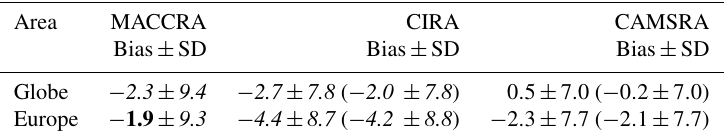
Figure 11. Time series of monthly mean surface ozone MNMB between the three reanalyses and GAW O 3 data averaged over (a) the globe and (b) Europe. Globally about 60–70 stations were available from 2003 to 2014, dropping to about 40–50 in 2015 and then dropping steeply to only a few during 2016. In Europe, the number dropped from 25–35 in 2003–2014 to 17–19 in 2015. CAMSRA is shown in red, CIRA in blue and MACCRA in green. Table 4. Mean biases and standard deviations from MACCRA, CIRA and CAMSRA relative to GAW surface O 3 data (shown in Fig. 11; in ppb). The values are calculated for the period 2003–2012, and the values in brackets are calculated for CIRA and CAMSRA for the period 2003–2016. Numbers in italics mark where MACCRA or CIRA have larger biases or a larger standard deviation than CAMSRA; numbers in bold mark where their values are